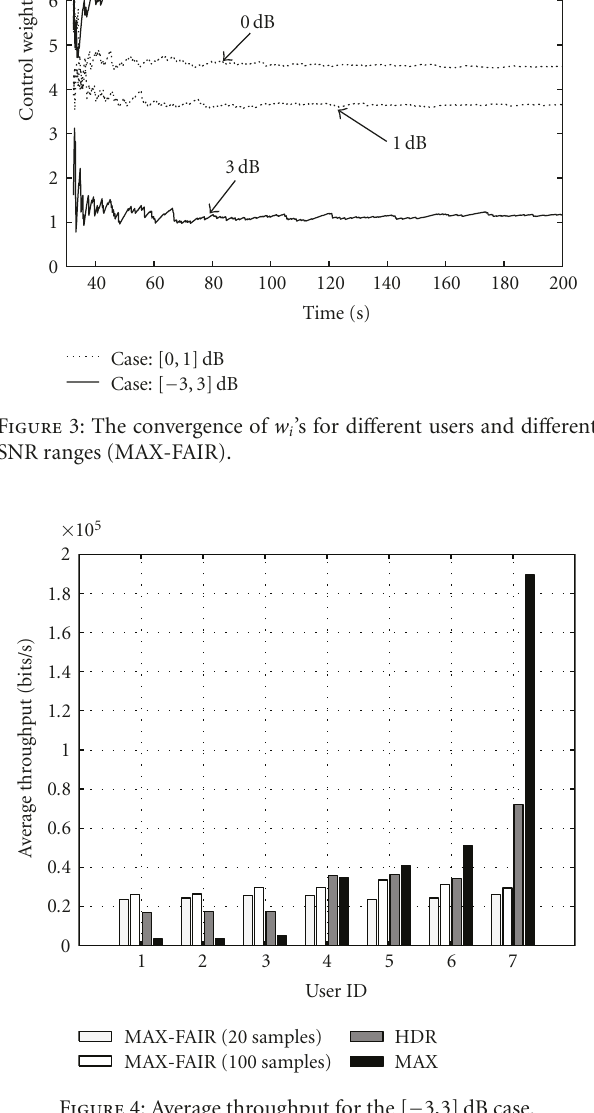
Figure 4: Average throughput for the [ − 3,3]dB case.